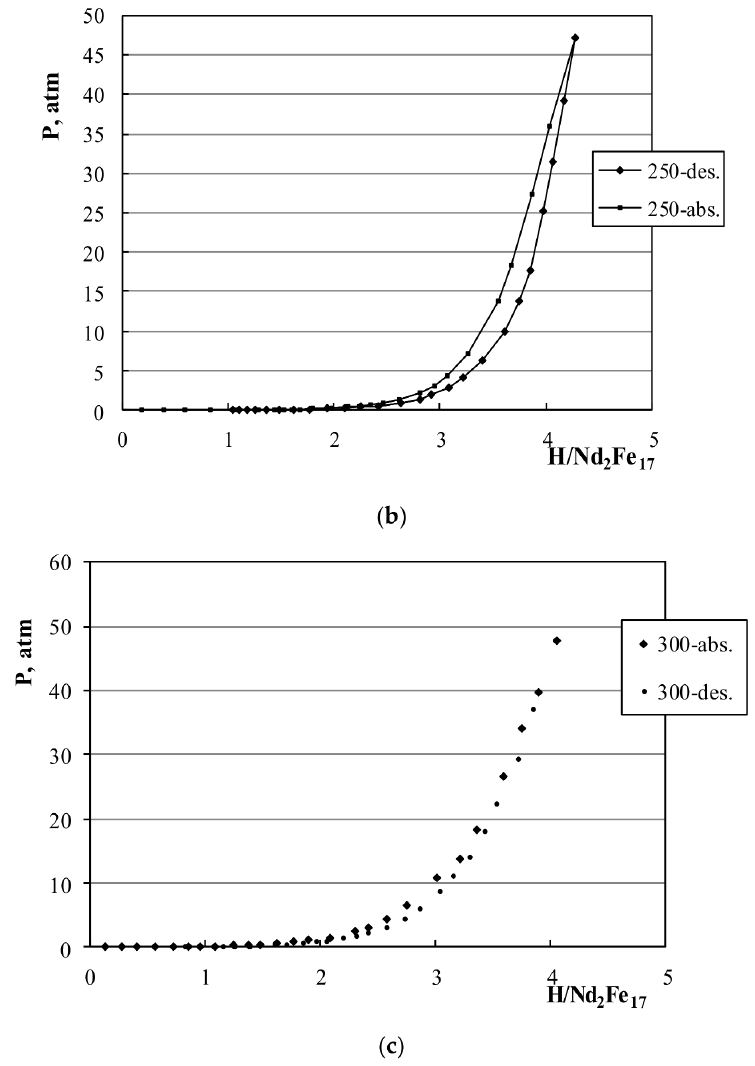
Figure 2. ( a ) Absorption and desorption isotherms for the Nd 2 Fe 17 -H 2 system at 200 ◦ C according to reference [8]; ( b ) absorption and desorption isotherms for the Nd 2 Fe 17 -H 2 system at 250 ◦ C; and ( c ) absorption and desorption isotherms for the Nd 2 Fe 17 -H 2 system at 300 ◦